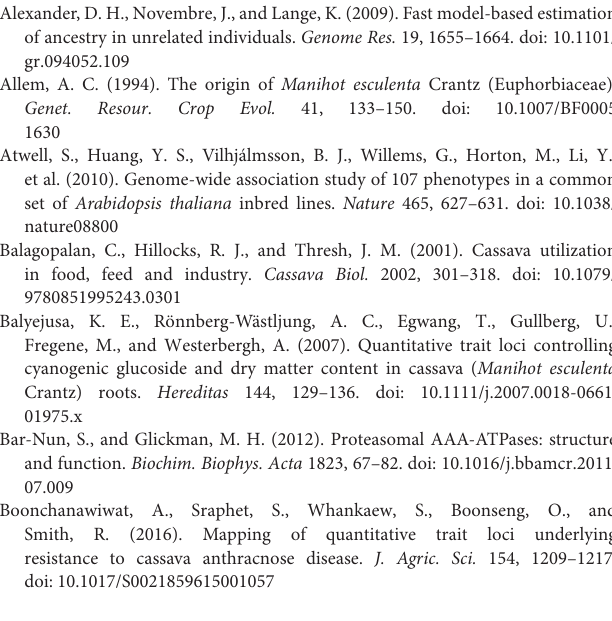
FIGURE S12 | Genome-wide association analyses on storage roots weight. (a) Manhattan plots of the simple model for storage roots weight. Negative log 10 -transformed P values from a genome-wide scan are plotted against position on each of the 18 chromosomes. Genome-wide significance threshold is depicted as a blue horizontal dashed line. (b) Quantile–quantile plot of the simple model for